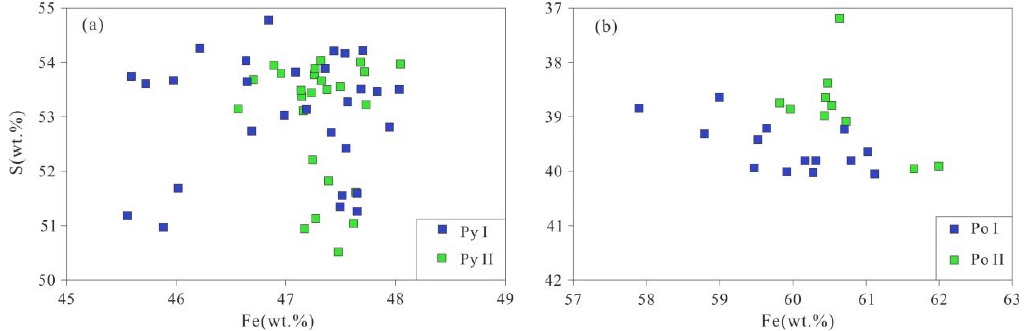
Figure 5. Fe vs. S diagrams for pyrite ( a ) and pyrrhotite ( b ) from massive and lamellar ores of the Dongguashan copper (gold) deposit.